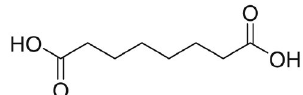
Figure 1. Chemical stucture of suberic